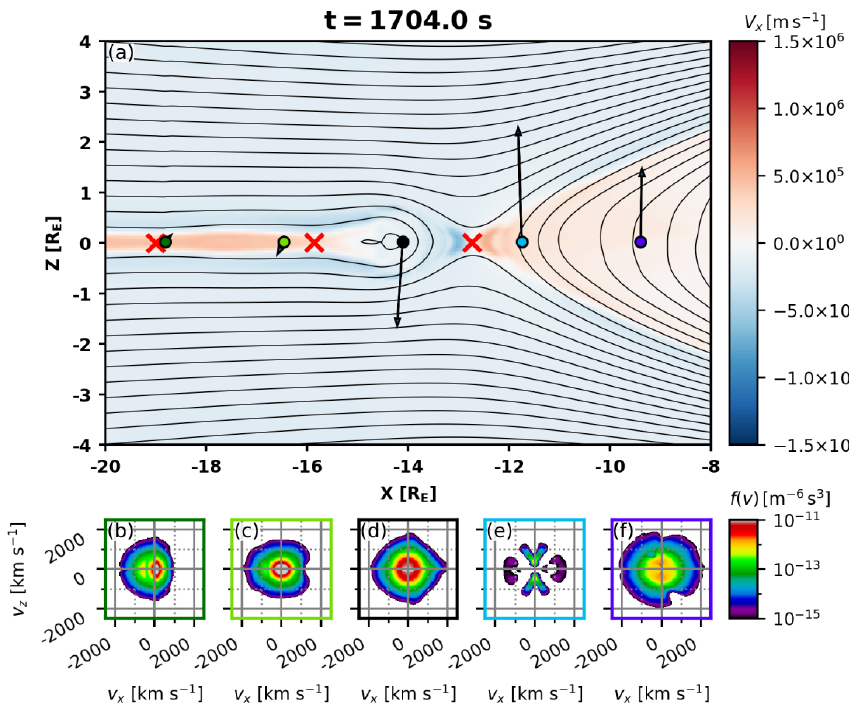
Figure 2. (a) X component of the plasma bulk velocity in the magnetotail at t = 1704 . 0s in the area depicted with a white rectangle in Fig. 1. Blue (red) colors illustrate tailward (earthward) plasma flows. The black contours show magnetic field lines and red crosses indicate X points. The black arrows show the direction and relative magnitude of the magnetic field projected into the XZ plane at the five locations indicated with colored circles. (b–f) Slices of the 3D VDFs (velocity distribution functions) in the { v x , v z } plane at those five locations. The VDFs are shown in the plasma frame.